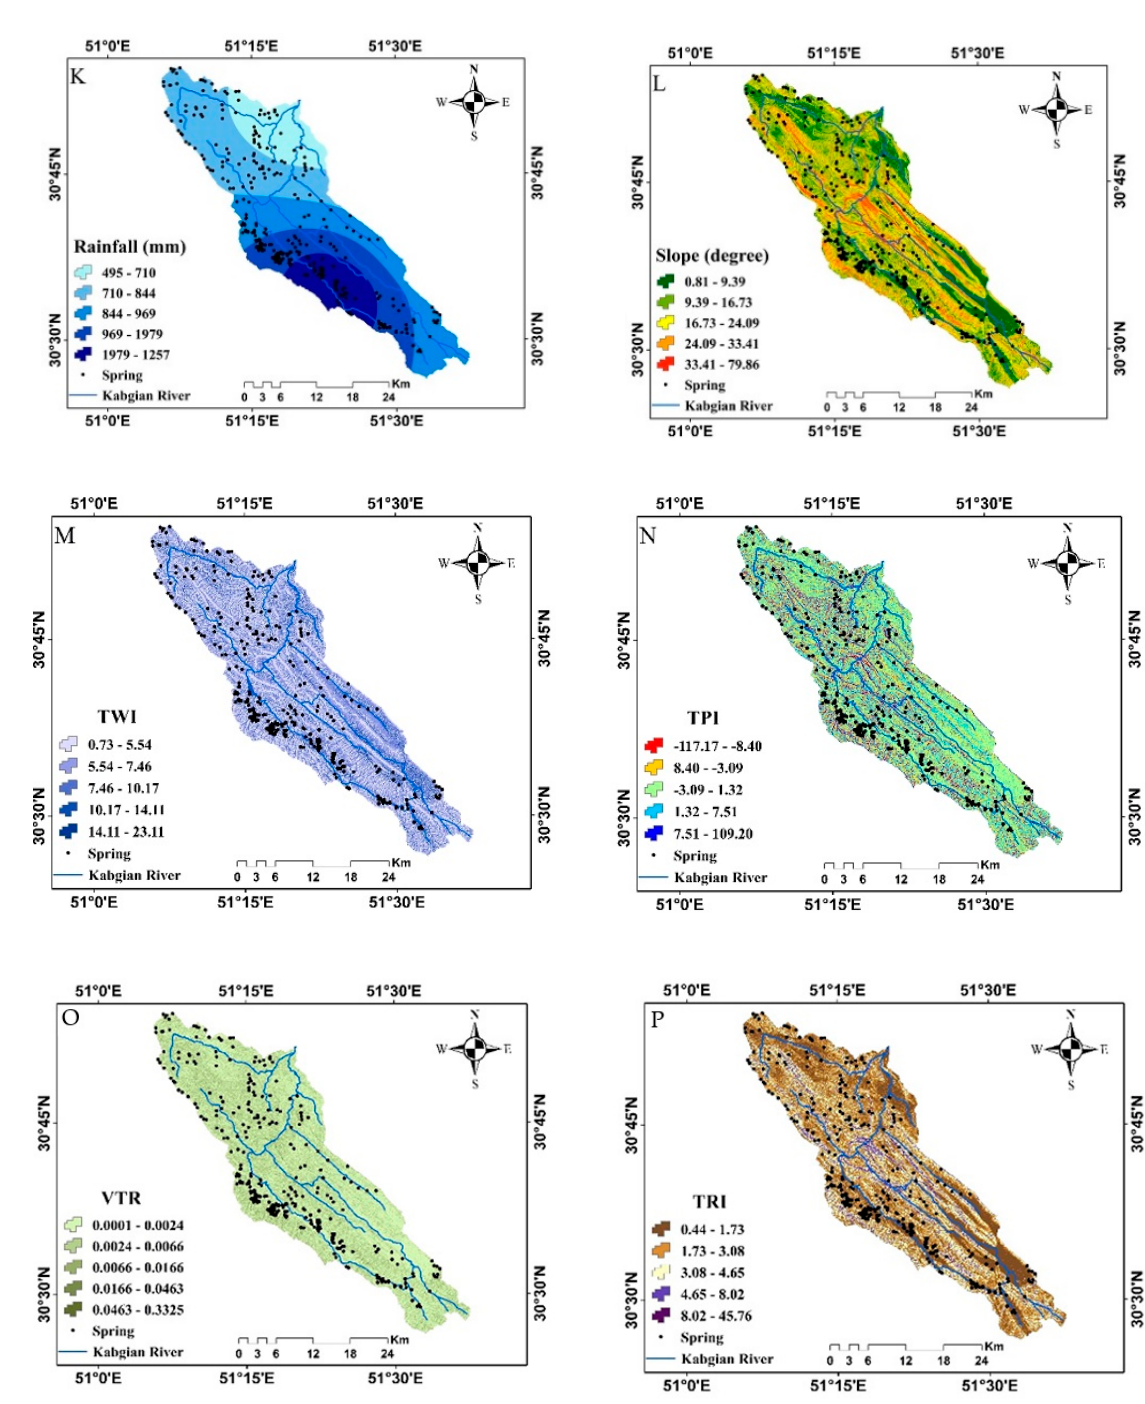
Figure 2. Factors influencing karst groundwater potential: ( A ) Elevation, ( B ) aspect, ( C ) curvature, ( D ) distance to lineament, ( E ) distance from stream, ( F ) distance to fault, ( G ) geology, ( H ) land use, ( I ) LST, ( J ) NDVI, ( K ) rainfall, ( L ) slope, ( M ) TWI, ( N ) TPI, ( O ) VTR, and ( P ) TRI.